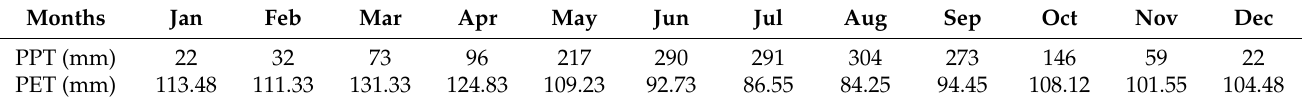
Table 3. Comparison of long-term (1961–1990) PPT and PET (NMA and FAO LocClim database).